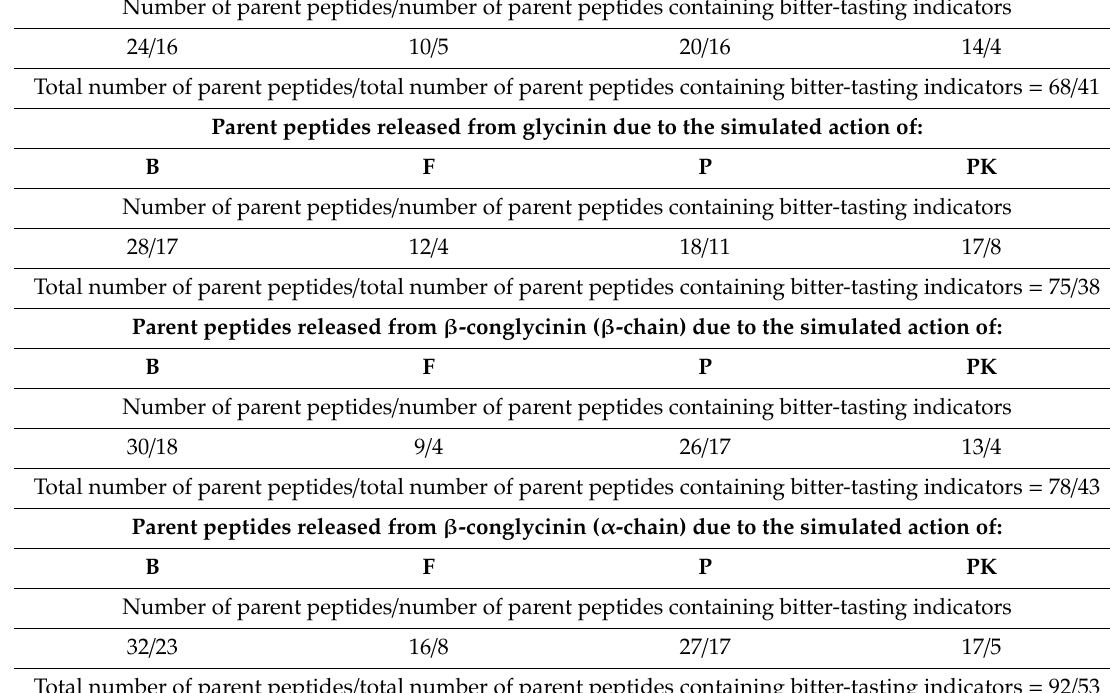
Number of parent peptides / number of parent peptides containing bitter-tasting